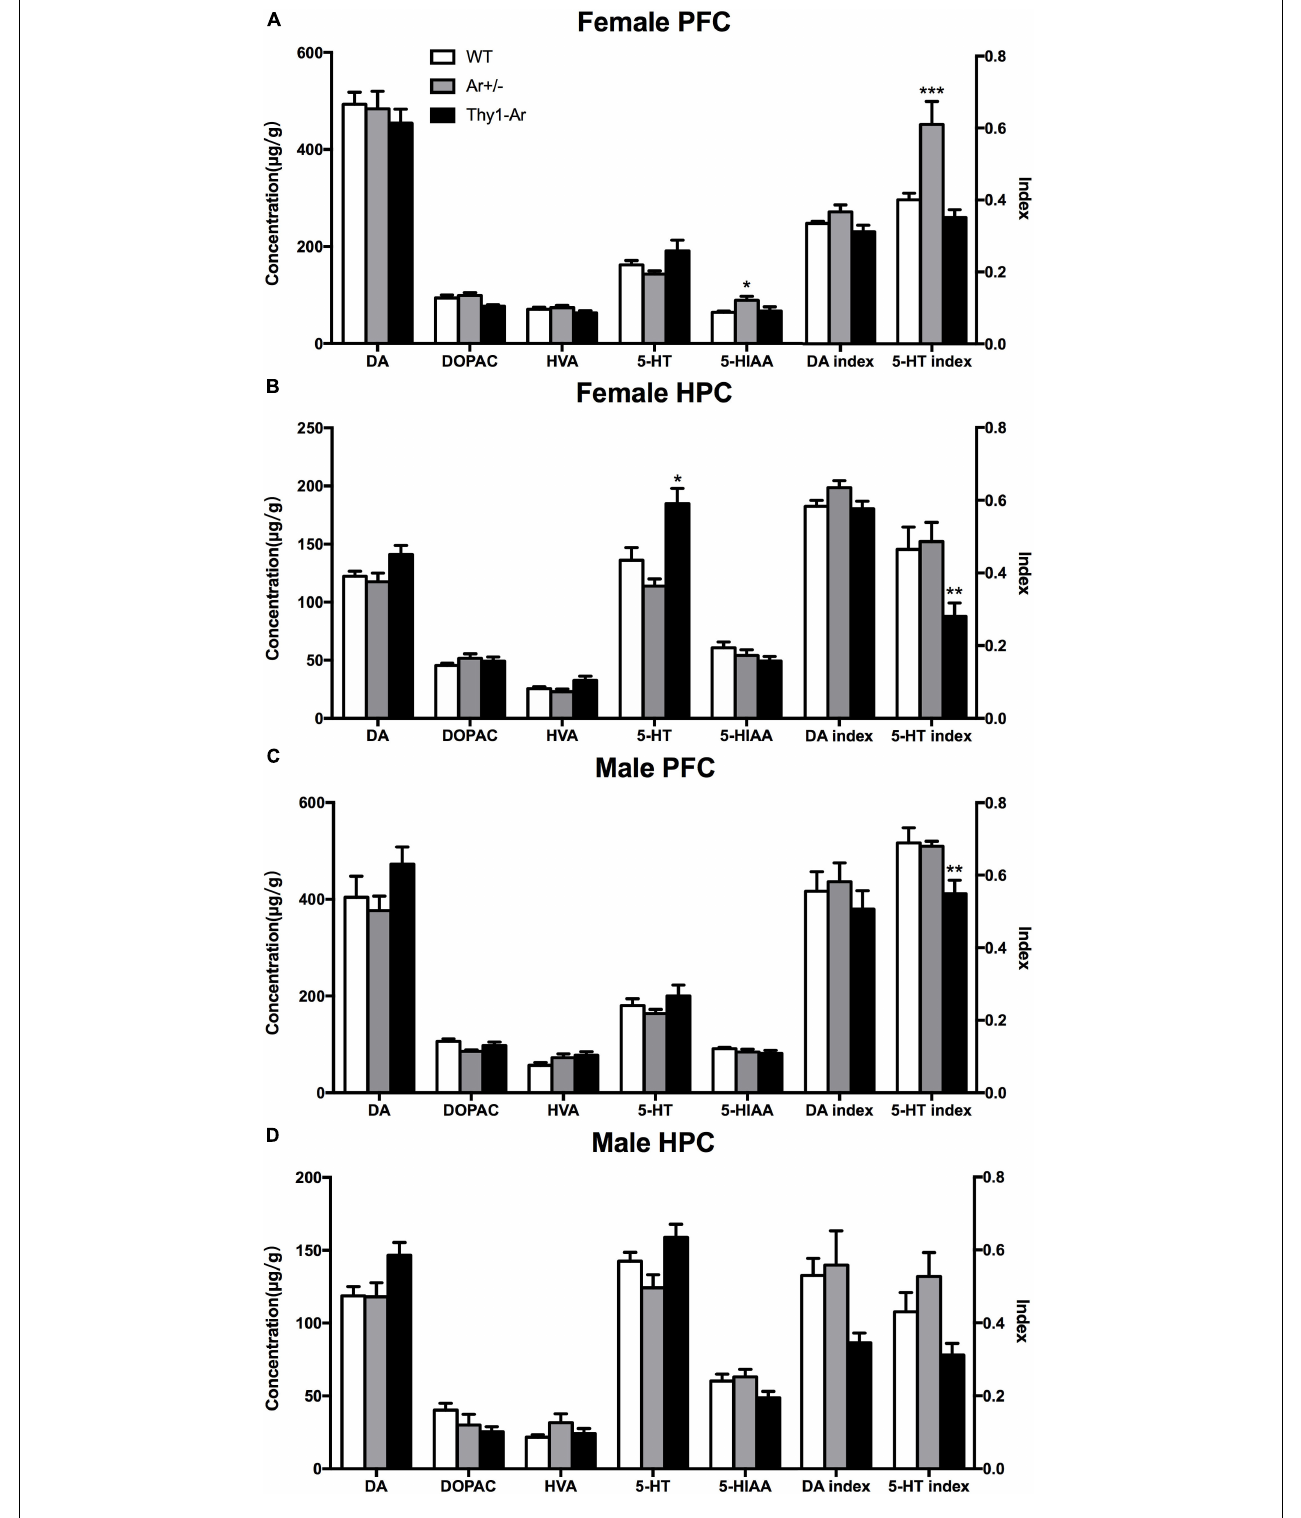
FIGURE 3 | Endogenous estrogen induced sex- and brain region-specific alterations in 5-TH systems. The concentration ( µ g/g) of DA and 5-TH related neurotransmitters affected by endogenous estrogen in (A) female PFC, (B) female HPC, (C) male PFC, and (D) male HPC. Data represent means ± SEM ( N = 6–7 mice/group), as evidenced by the two-way ANOVA followed by Bonferroni post hoc test. ∗ P < 0.05, ∗∗ P < 0.01, ∗∗∗ P < 0.001 versus WT mice.